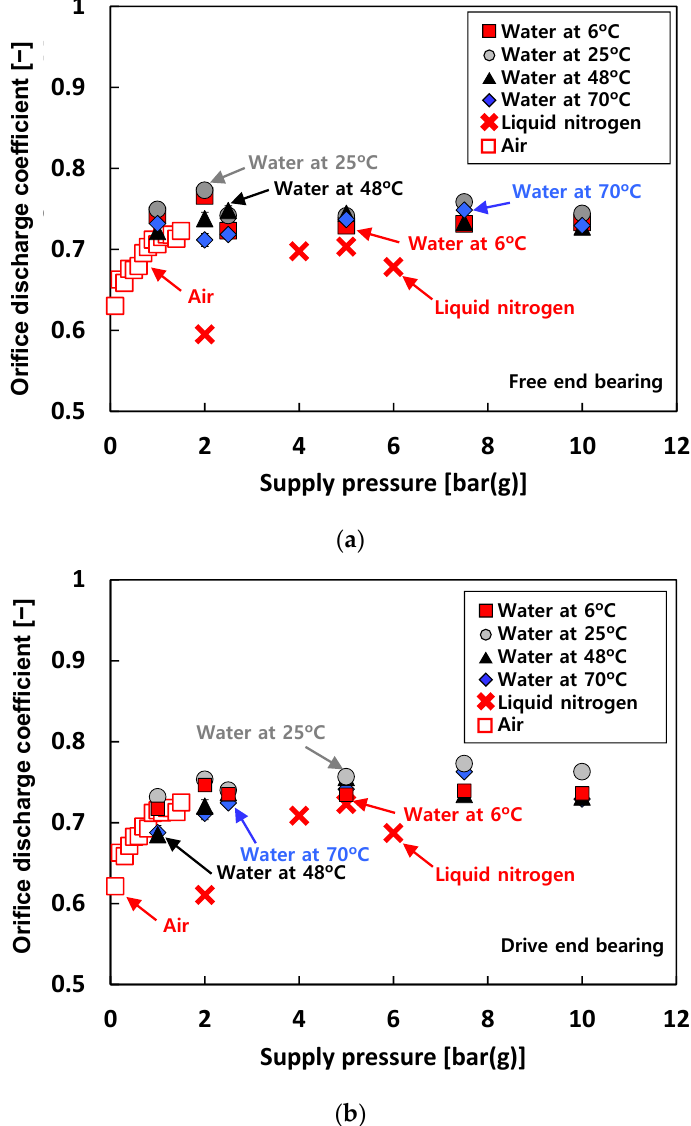
Figure 6. Test cases #1 through #3: estimated orifice discharge coefficient ( C d ) versus supply pressure ( P s ). ( a ) Free end bearing. ( b ) Drive end bearing. Note: The lowest value of the Y -axis is not 0 but 0.5. Figure 8 depicts the measured eccentricity ratio versus P s for the free end